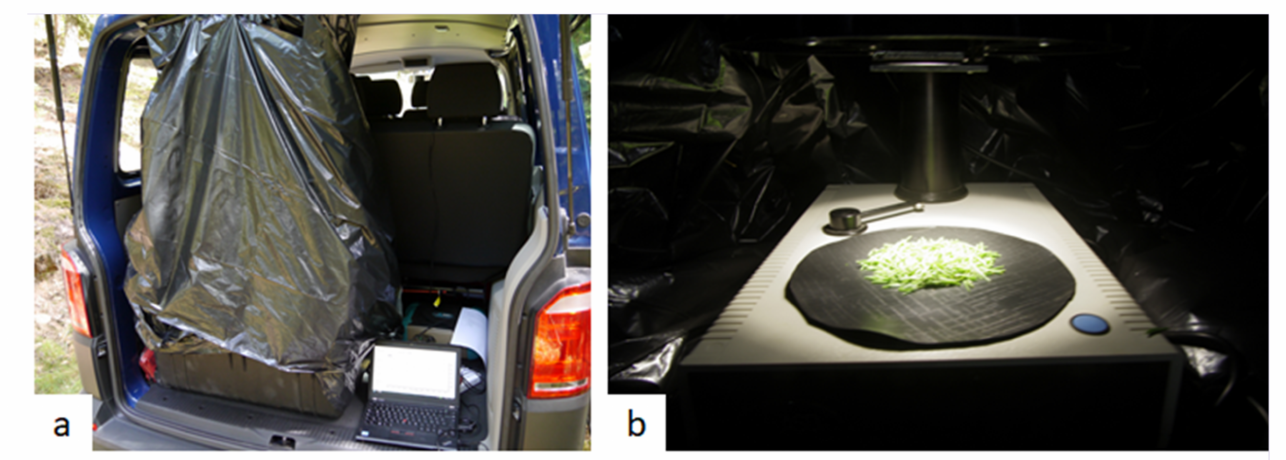
Figure 4. Experimental setup. ( a ) Darkened cabin for the ASD Fieldspec 3; ( b ) needle sample on the FieldSpec plate. The FS 3 provides spectral data in the wavelength ( λ ) range from 350 to 2500 nm. The full-width-half-maximum spectral resolution was about 3 nm and 10 nm in the visible near-infrared range ( λ = 350–1000 nm) and the SWIR range ( λ = 1001–2500 nm), with a sampling interval of 1.4 nm and 2 nm, respectively [40]. The probe end of the 2 m long FS3 fiber cable with a 25 ◦ field-of-view [40] was fixed in the sample turntable at a nadir angle of 35 ◦ . The perpendicular distance between the fiber cable probe end and the surface of the rotatable Turntable disk was 0.11 m. At the same height, above the measurement spot on the turntable disk, a downward radiating halogen lamp (Reflekto EXT/C/A/FG; Ushio) was installed, enabling the illumination of the sample at a color temperature